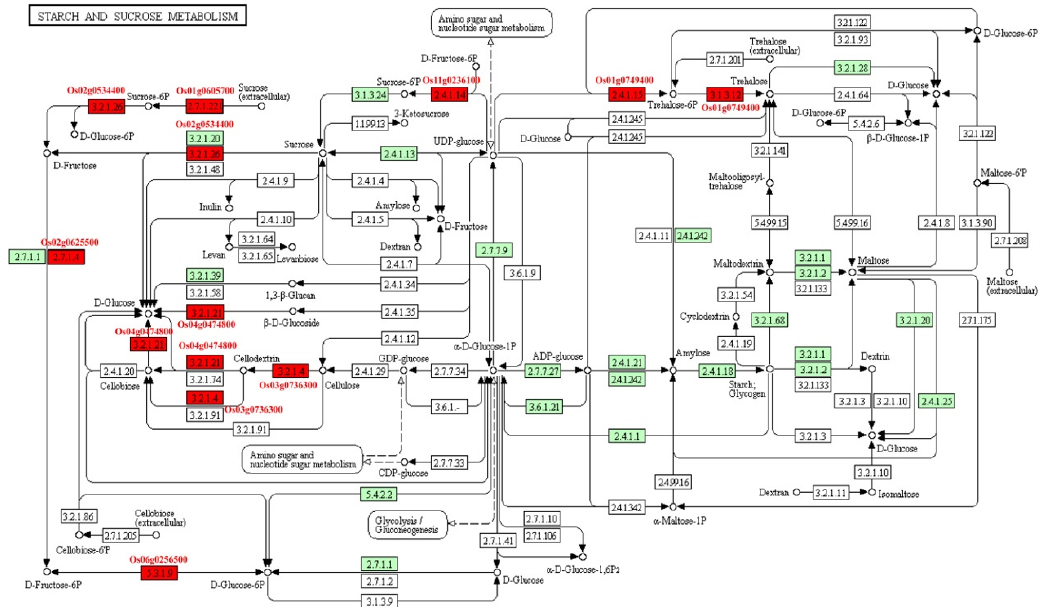
Figure 7. The pathway of starch and sucrose metabolism. Red box, MEGs involved in the pathway; Green box, the enzymes involved in starch and sucrose metabolism existed in rice; White box, the enzymes existed in other species.